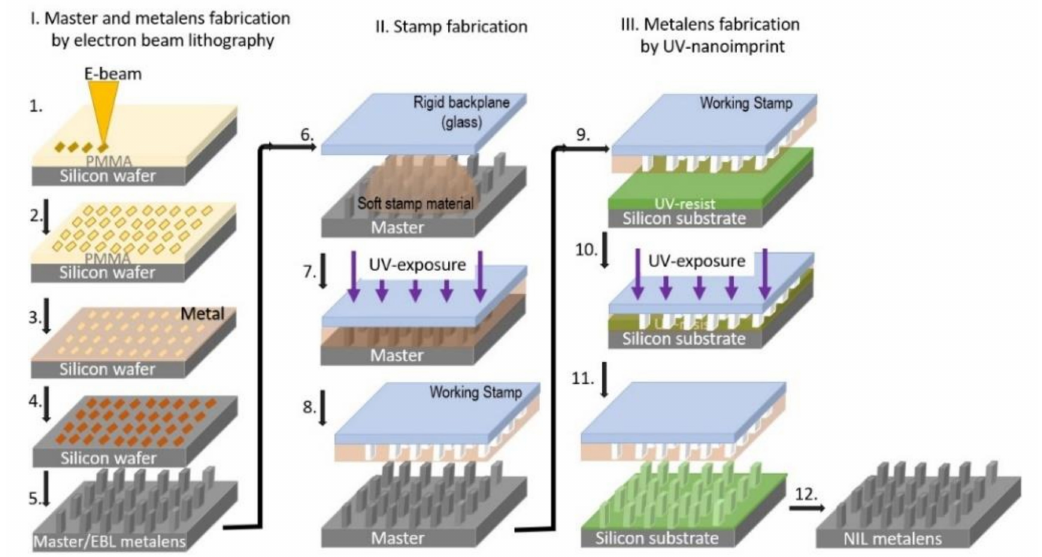
Figure 3. Sketch of the experimental steps used to pass from the EBL to UV- NIL: 1. Resist deposition and further electron beam exposure; 2. Developing of the exposed PMMA resist; 3. Masking layer deposition; 4. Lift-off; 5. Silicon cryogenic etching process with O 2 and SF 6 and reactive ion etching to completely remove the masking layer; 6. Dropcast of the soft stamp material (UV-PDMS) on the master template; 7. UV-curing of the soft stamp material; 8. Demolding the rigid backplane with the soft stamp material on top (working stamp) from the master template; 9. Alignment of the working stamp and the resist-coated substrate; 10. Contact between the working stamp and resist followed by resist curing; 11. Detachment of the working stamp from the patterned substrate; 12. Residual layer removal by reactive ion etching, silicon cryogenic etching process with O 2 and SF 6 and reactive ion etching to completely remove the resist